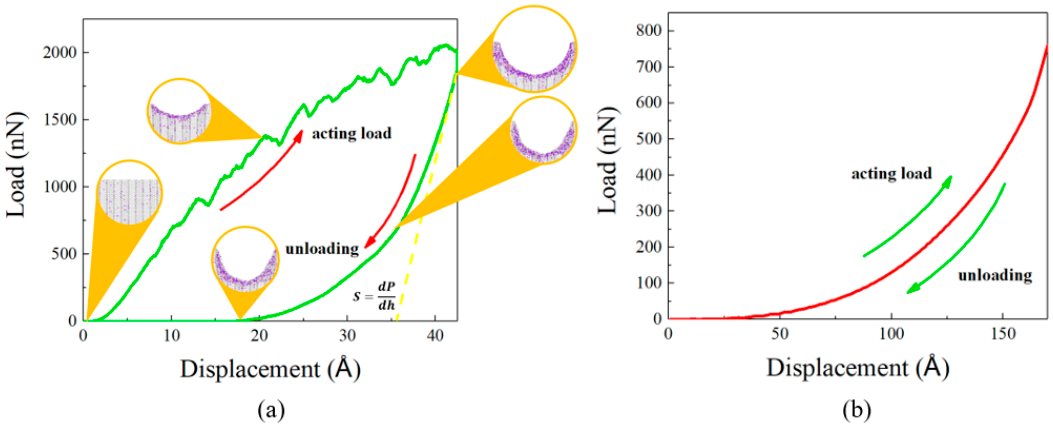
Figure 5. ( a ) The acting–load curve and unloading curve. The slope of tangent line at the initial stage of unloading refers to the contact stiffness S = dP dh . In addition, several snapshots of the morphology of in situ indentation are exhibited here, in which the color of atoms distinguishes different crystal lattices, with grey referring to normal CHC lattice, while purple refers to simple cube lattice, which is a more compact type than the normal one. For comparison between 2D and 3D graphene, the displacement–load curve of graphene under the same simulation condition is displayed in ( b ).